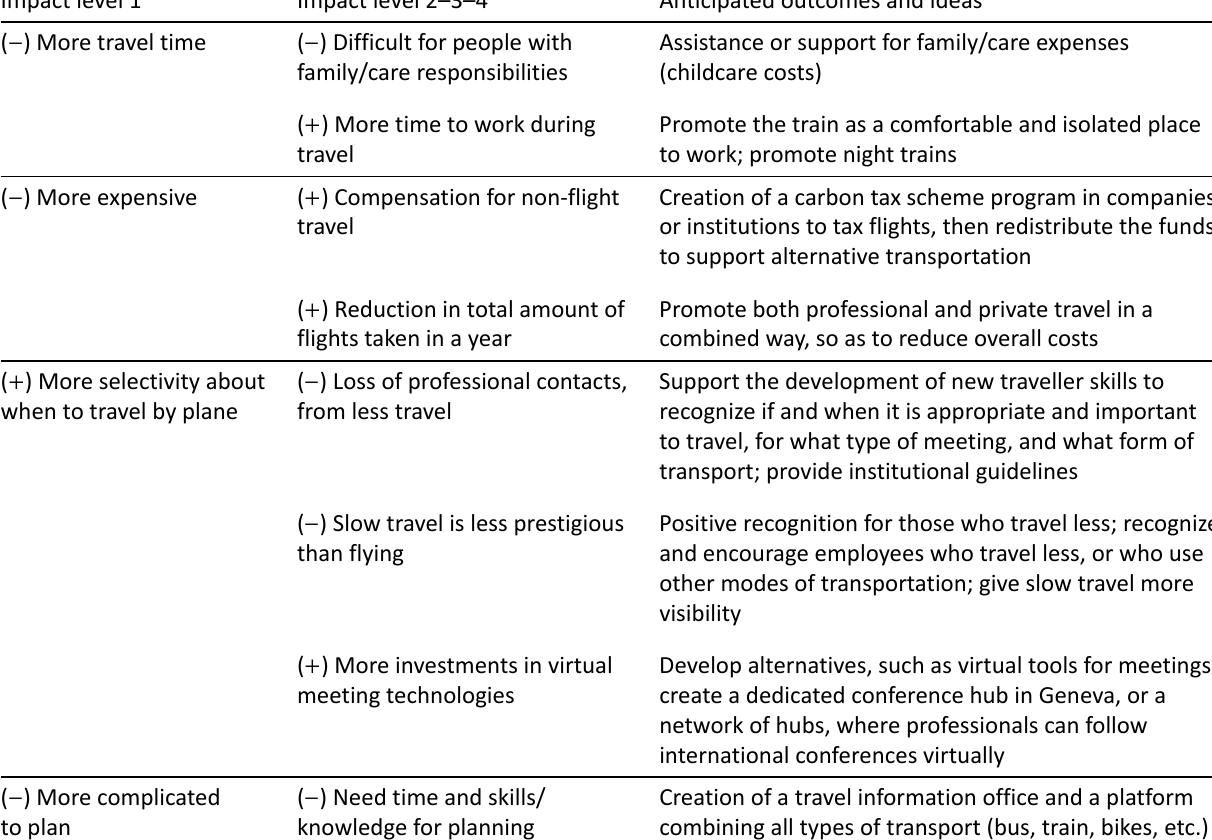
Table 2. Reducing flights for professional travel: Different levels of negative or positive impacts and anticipated outcomes and